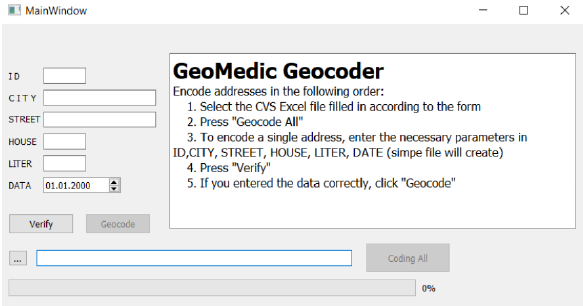
Figure 1. Tourist map is used to show spatial distribution of tuberculosis patients (Admiralteysky district of St. Petersburg)